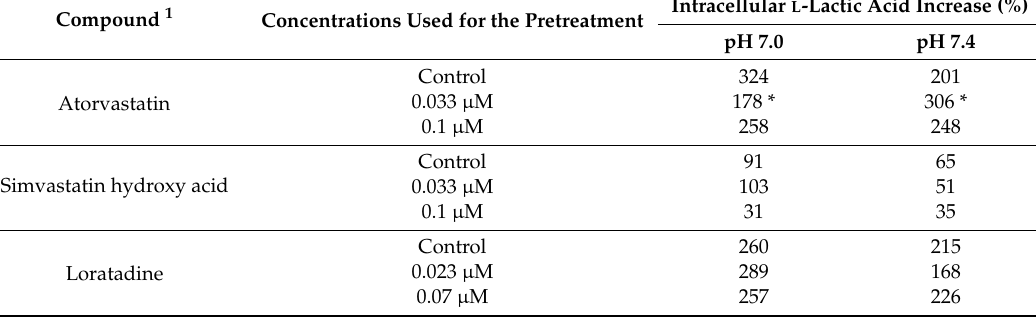
Table 2. Intracellular L -lactic acid increase (%) during L -lactic acid efflux inhibition studies following a six-day pretreatment with atorvastatin, simvastatin hydroxy acid and loratadine in SkMC at pH 7.0 and pH